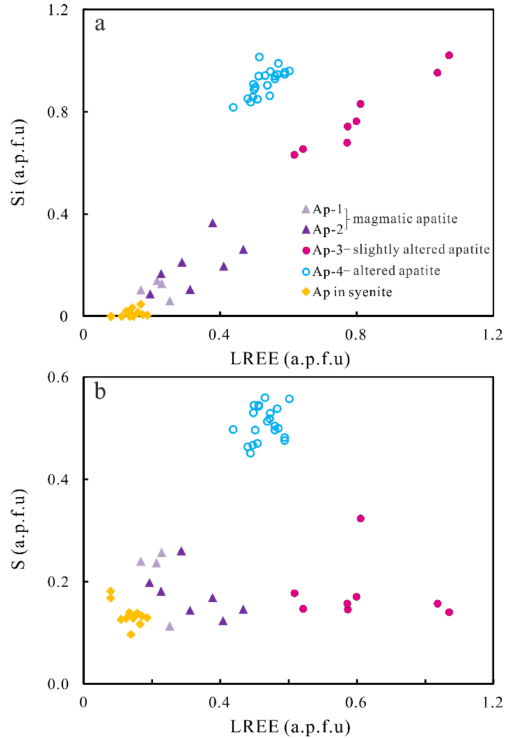
Figure 7. Major element compositions of apatite within magnetite-apatite-enriched rocks and syenites. ( a ) The plot illustrates the correlated increases in LREE and Si in apatite; ( b ) the plot shows the relatively consistent S content in magmatic and slightly altered apatite (Ap-1, Ap-2 and Ap-3) and the correlated increases in S and LREE contents for altered apatite (Ap-4).